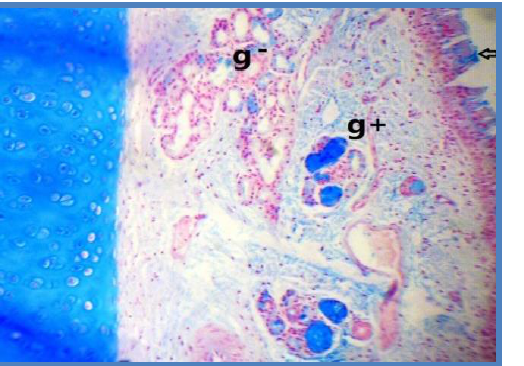
Figure (4): Histological section of nasal cavity (respiratory) showing: c-ciliated columnar cell, s- sustentacular cell, b-basal cell g-goblet cell,m- mucous gland, se-serous gland, d-duct (H&EX100)